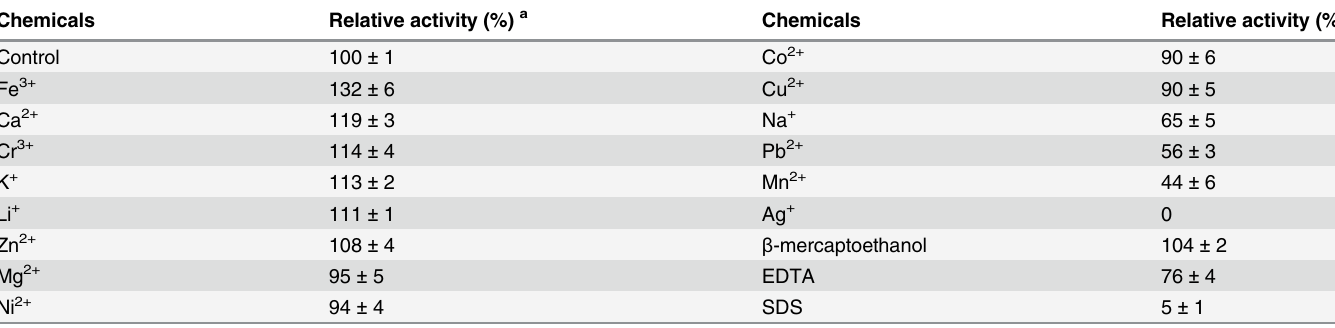
Table 2. The effect of metal cations and reagents (5 mM) on the activity of recombinant Egl7A.